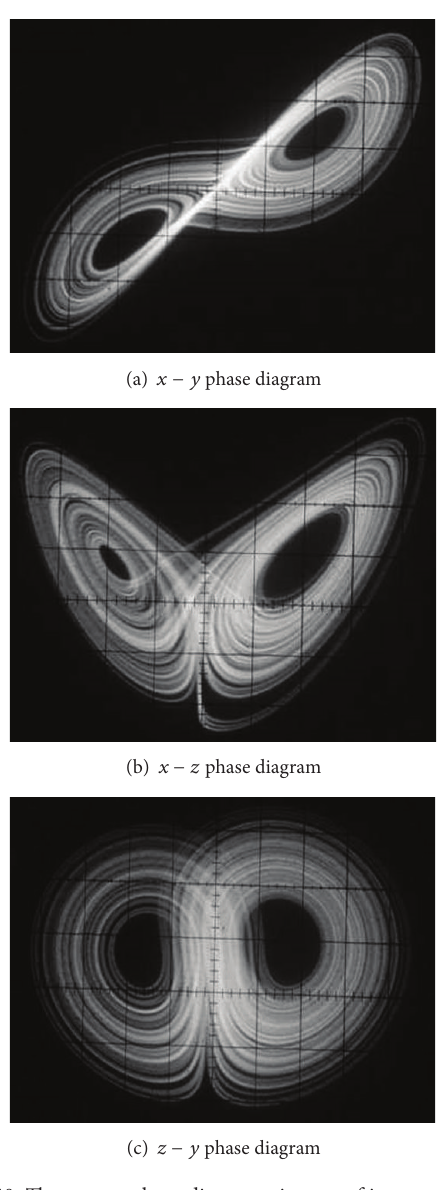
Figure 10: The output phase diagram pictures of improved Lorenz circuit experiment